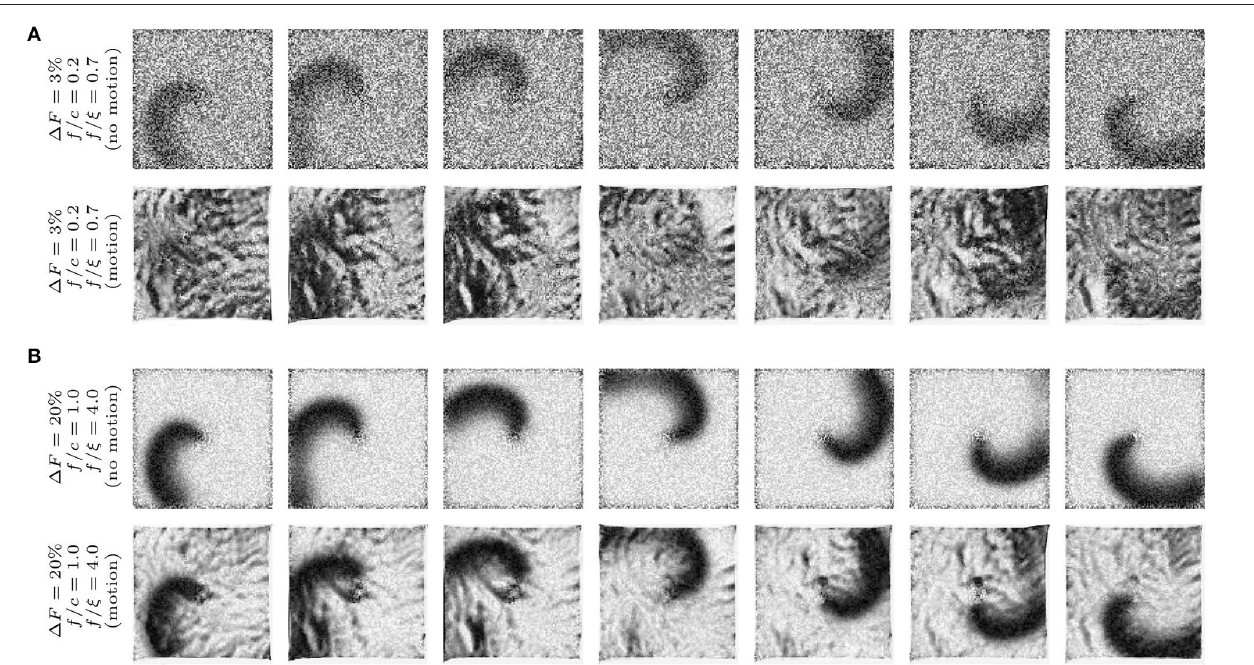
FIGURE 3 | Synthetic optical mapping videos (pixel-wise normalized) with simulated spiral waves on a deforming heart surface. The spiral wave pattern is caused by electrical activity and displayed as an intensity decrease which is typically seen during voltage-sensitive optical mapping. Clockwise rotating spiral wave with two different signal strengths f : (A) weak signal ( 1 F / F = 3 % ) and (B) strong signal ( 1 F / F = 20 % ) on non-deforming (top sequence) and deforming (bottom sequence) heart surface. The noise ξ is constant in all image sequences ( ξ = 0.03) even though it appears to be stronger in (A) due to the pixel-wise normalization (pixel intensities I ∈ [0,1] dimensionless normalized units, n.u.). The amplitude of motion is the same in all image sequences ( |E u | ≈ 3 − 5 pixels). On the deforming surface the spiral wave pattern is superimposed by motion artifacts. (B) Due to the large signal strength f , the spiral wave is still visible on the deforming medium and motion artifacts are comparatively low. The amount of motion artifacts depends on the signal-to-contrast ratio f c = | f | / c , the ratio of fluorescence signal strength f to the strength of the local contrast c or short-scale intensity gradients in the image ( c constant in all images).